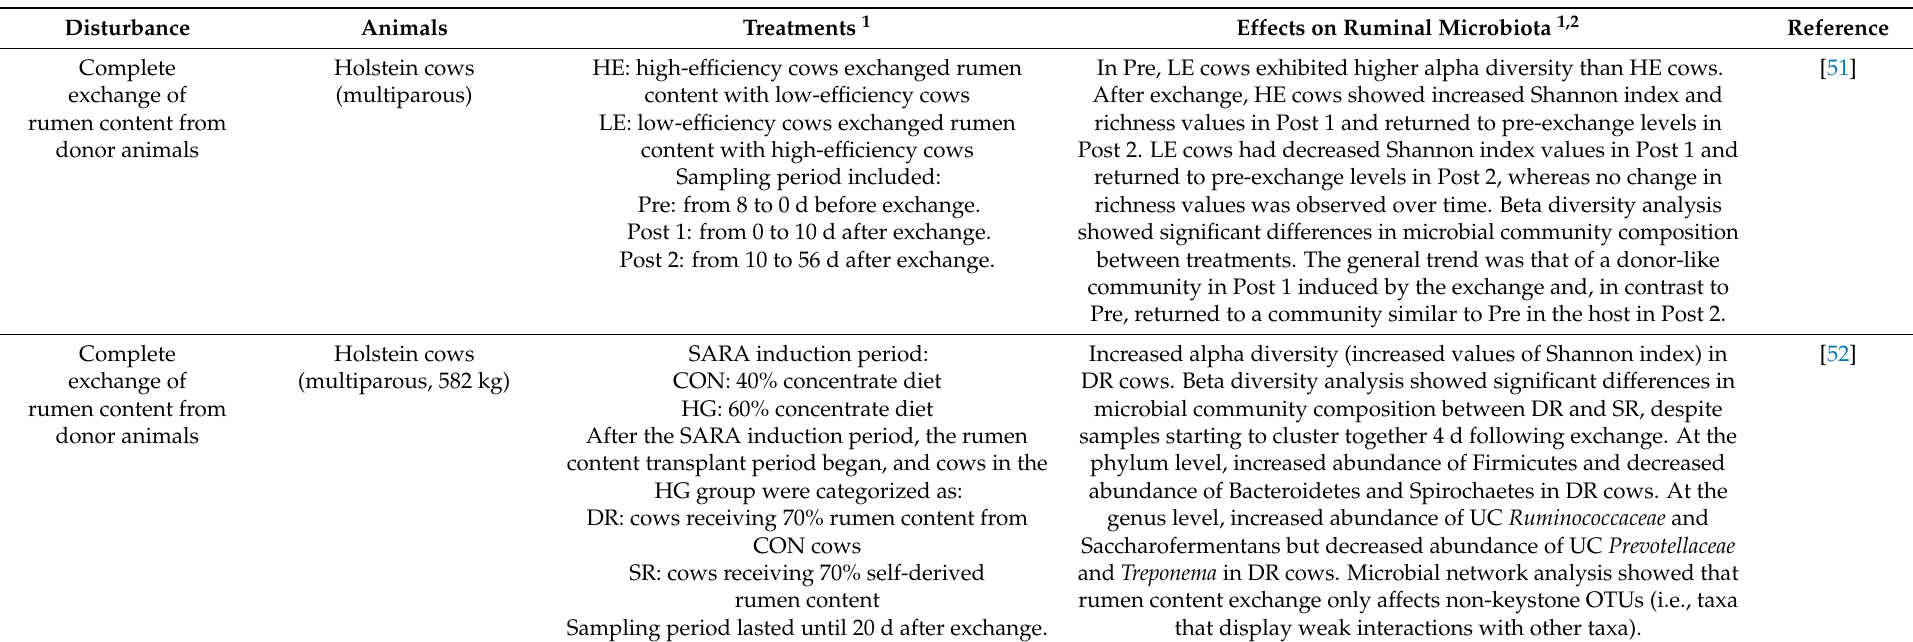
Table 4. Main effects of large, infrequent disturbances on ruminal microbiota (bacteria and